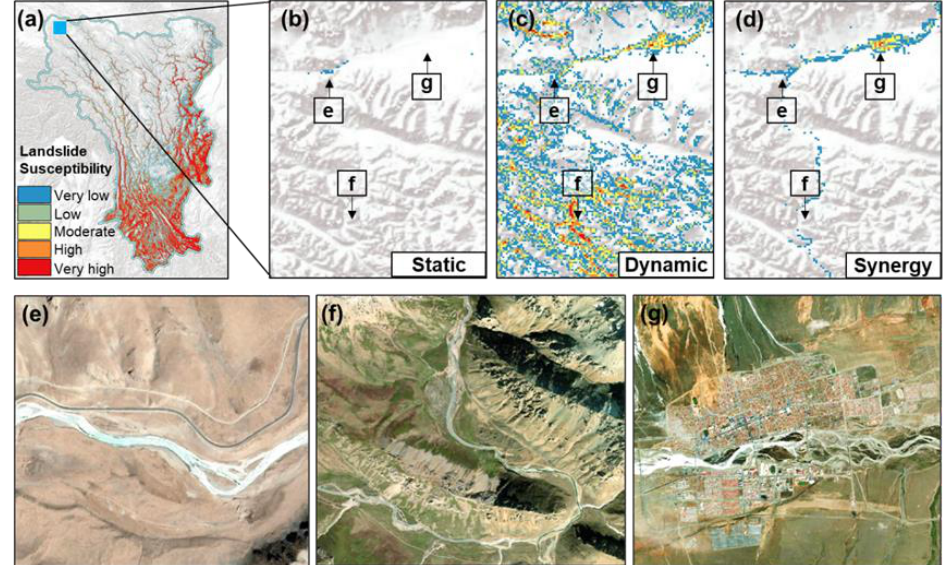
Figure 11. Landslide susceptibility assessment results and comparison with investigation landslide data. Predict label values 0 and 1 represent landslide non-occurrence and landslide occurrence respectively .